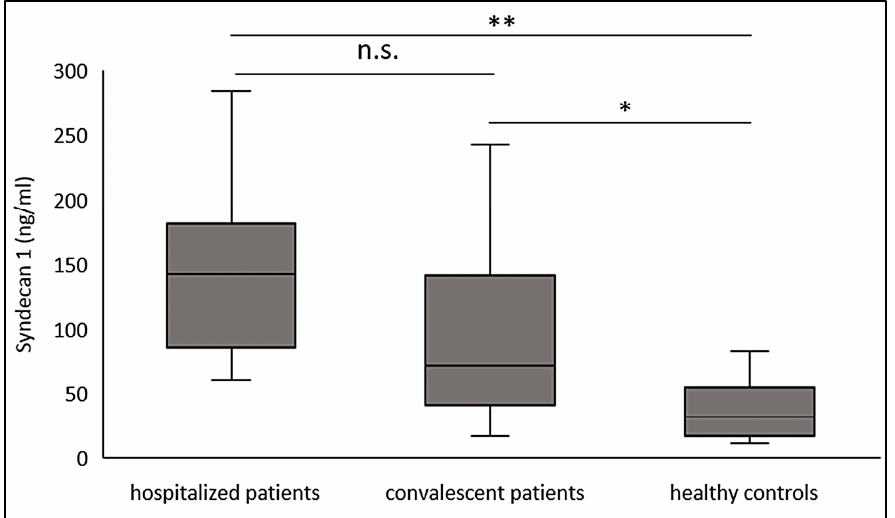
Figure 1. SDC-1 values of COVID-19 inpatient convalescent patients, hospitalized patients with